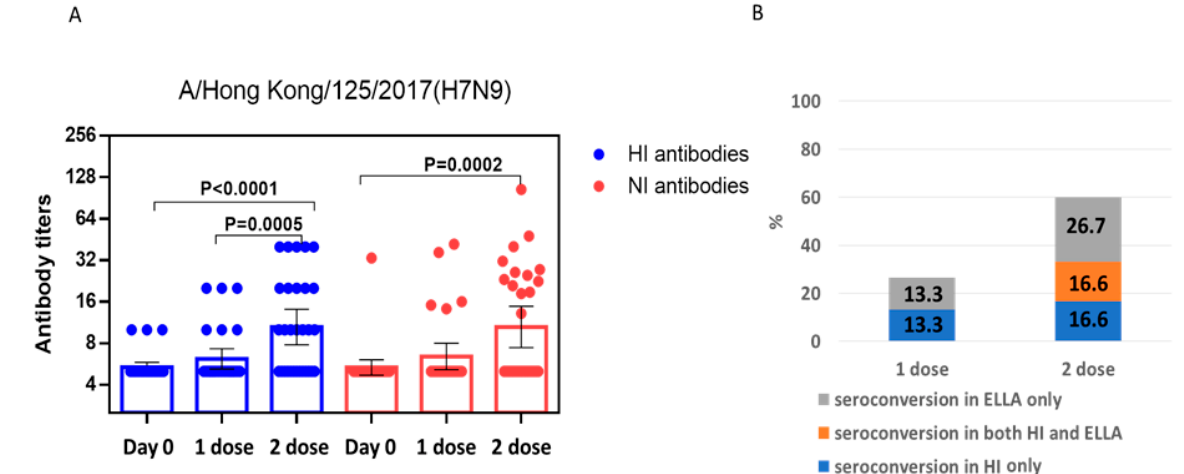
Figure 4. Serum antibodies after immunization with the first dose and the second dose of LAIV based on A/Hong Kong/125/2017(H7N9) ( n = 30). ( A ) HI and NI antibody titers. Geometric means with 95% CI are presented. A four-fold increase in titer was considered a significant conversion for HI antibodies, and a two-fold increase in titer was considered a reliable conversion for NI antibodies. ( B ) Coincidence of HI and NI seroconversions (%) is presented.